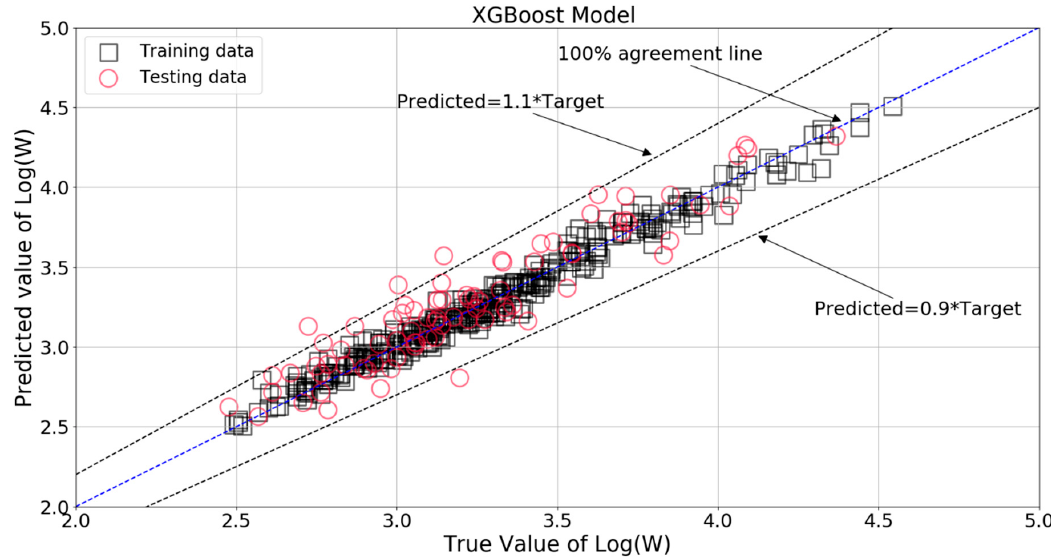
Figure 25. Comparison between the target and XGBoost model predicted Log(W).